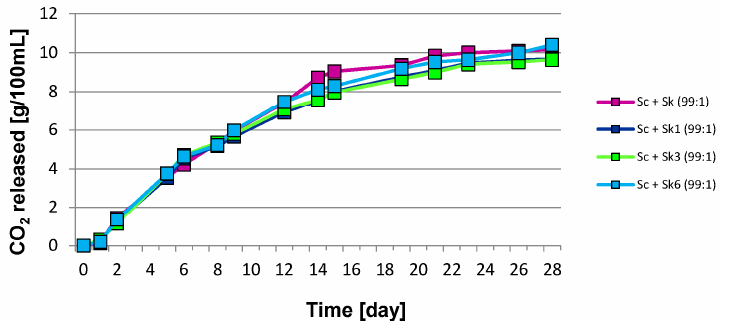
Figure 2. The kinetics of grape must fermentation with mixed cultures of S. cerevisiae (Sc) and S. kudriavzevii (Sk) with an initial yeast ratio 99:1. Due to the differences in the course of fermentations, depending on the use of mono- and mixed cultures, inoculated simultaneously or sequentially, the wine samples were characterized by significantly differentiated ethanol yield. The ethanol content in the wines analyzed ranged from 8.7 to 11.2% v / v (Table 1). The highest concentrations of ethyl alcohol were observed in wines sequentially inoculated with S. kudriavzevii on the sixth day after inoculation with S. cerevisiae .